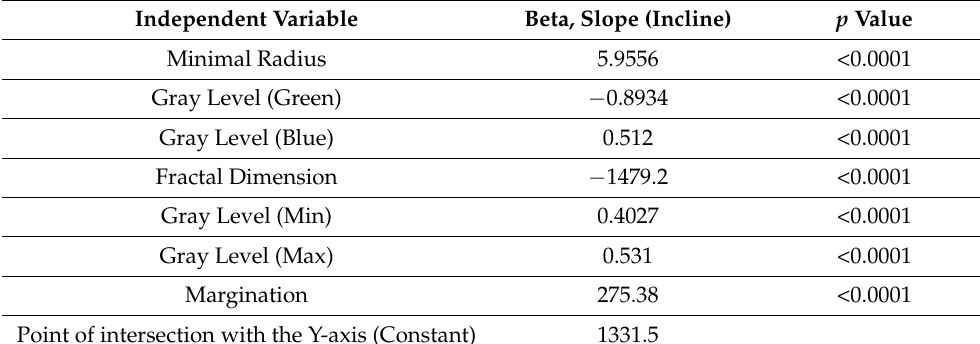
Table 2. Multivariate analysis results.